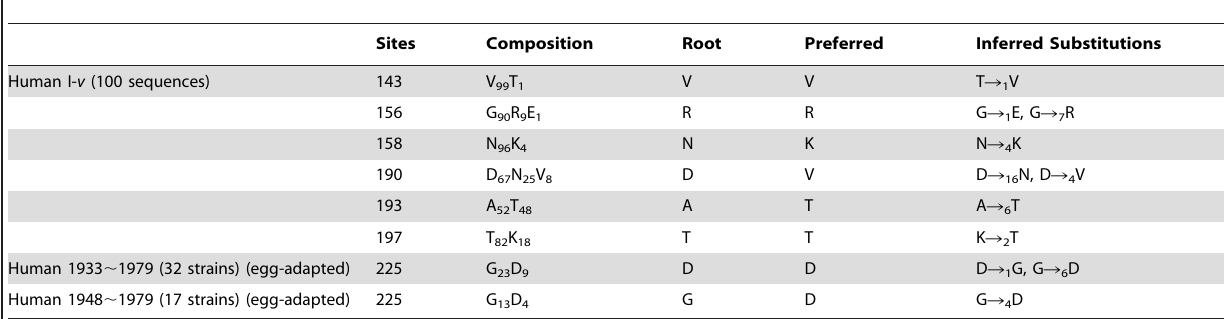
Table 9. Sites found to be under directional selection in human A(H1N1)